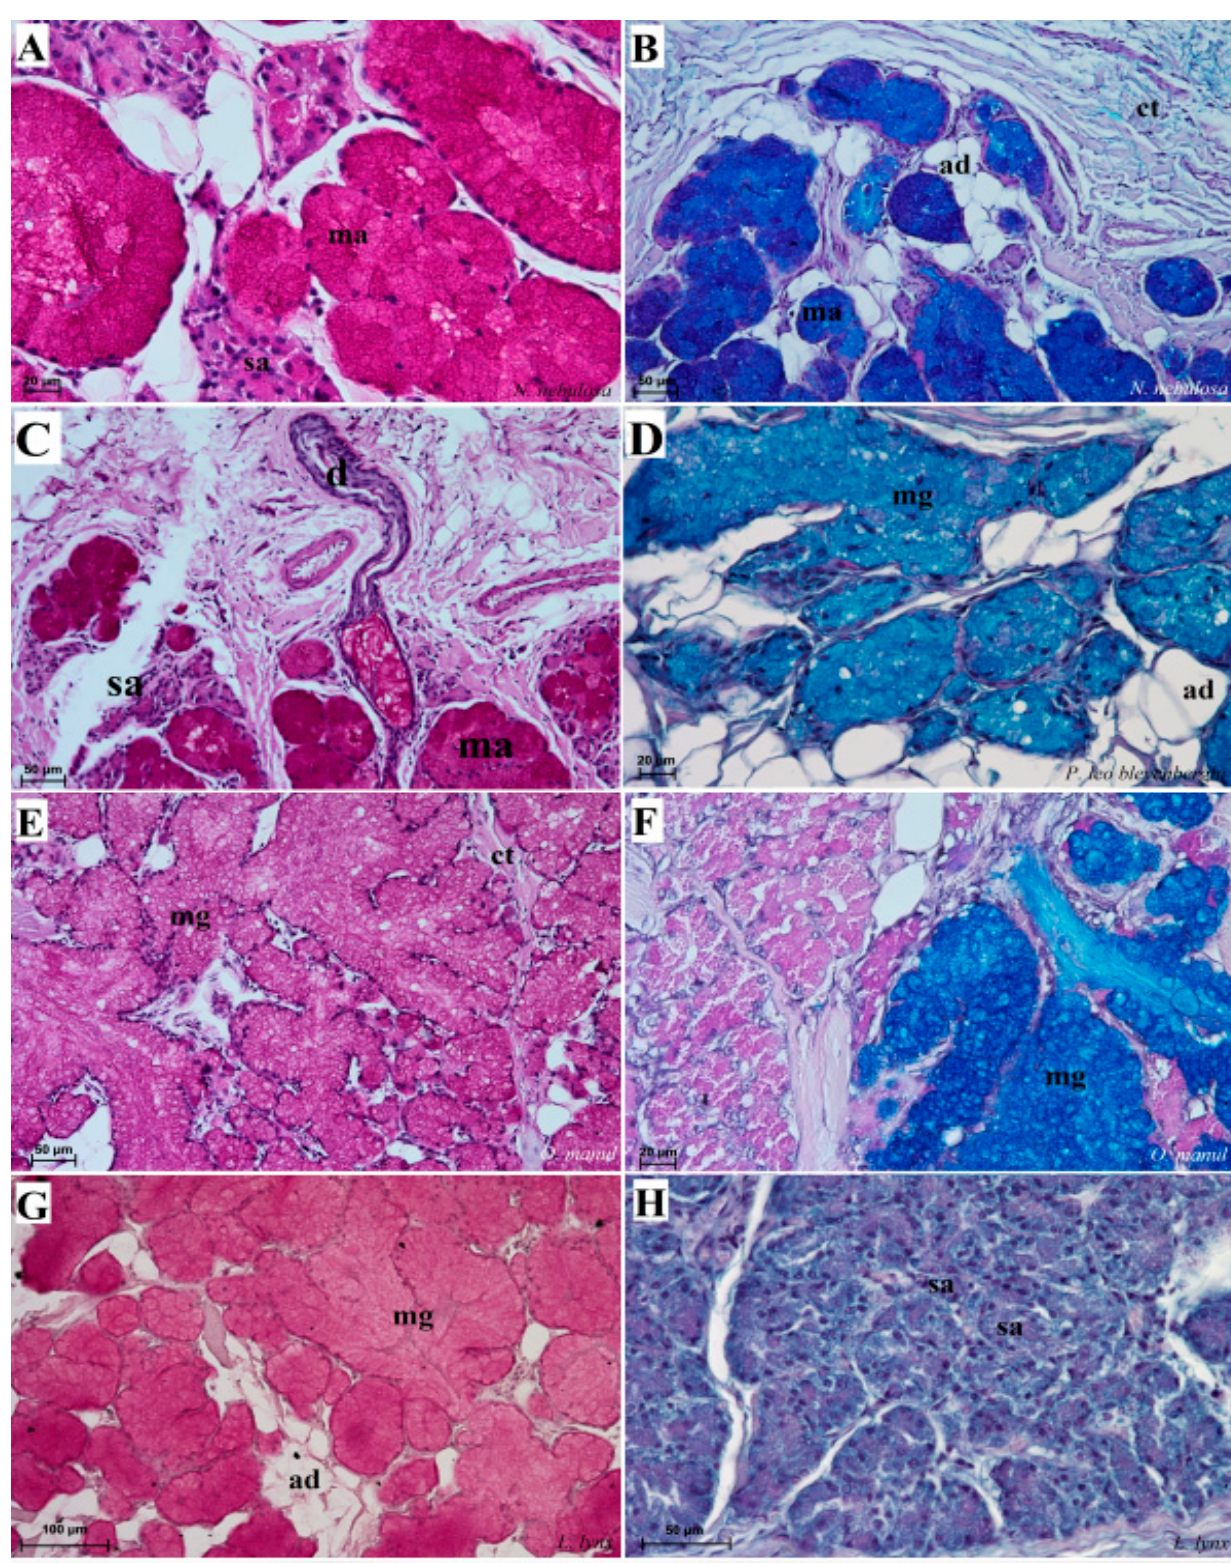
Figure 13. Histochemical analysis (PAS staining, PAS-AB pH2.5 staining) of the mucous synthesis in the posterior lingual glands of the four species of undomesticated Felidae: N. nebulosa ( A , B ), P. leo bleyenberghi ( C , D ), O. manul ( E , F ) and L. lynx (G,H). ( A ) Strong positive reaction (+++) in mucous acini (magenta) and weakly positive reaction (+) in serous acini. ( B ) Strong positive reaction (+++) in mucous acini (dark blue). ( C ) Positive reaction (++) in mucous acini (magenta). ( D ) Positive reaction (++) (blue) in mucous acini. ( E ) Positive reaction (++) in mucous acini (light magenta). ( F ) Strong positive reaction (+++) (dark blue) in mucous acini and negative reaction ( − ) in serous acini. ( G ) Weakly positive reaction (+) (light magenta) in mucous acini. ( H ) Negative reaction ( − ) in serous acini. PAS staining ( A , C , E , G ); PAS-AB pH2.5 staining ( B , D , F , H ). Bar = 100 µm (G); bar = 50 µm (B,C,D,E,H); bar = 20 µm (A,F). Abbreviations: ct—connective tissue, m—muscle fibers, ma—mucous acini, mg—mucoserous glands with the dominance of mucous acini, sa—serous acini, sg—serous glands.